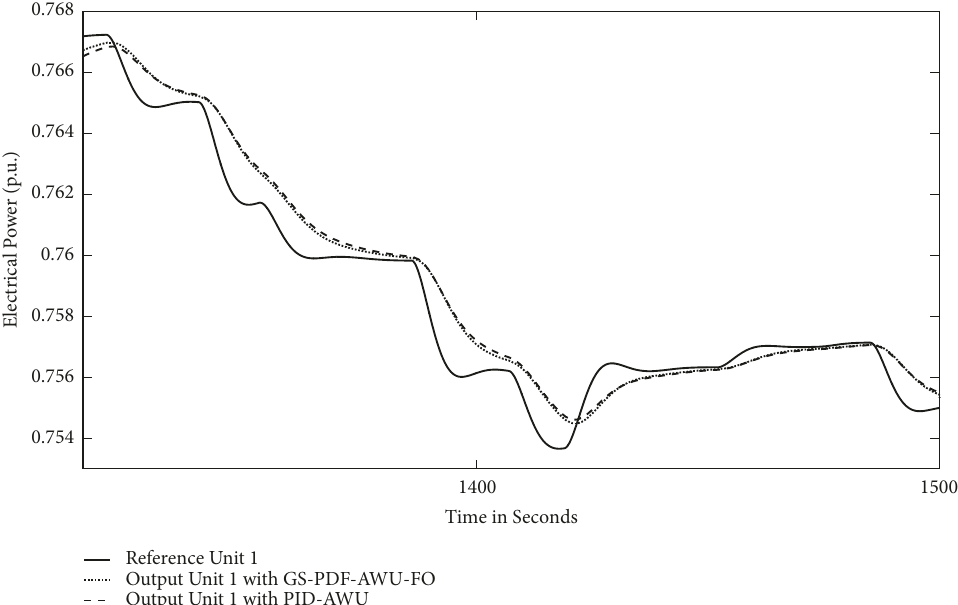
Figure 18: Evaluation of the responses produced by PID and GS-PDF-FO (both with antiwindup) with unit 1 in frequency variation (connected to the grid) and units 2-6 with 0.85 p.u. of fix operational point, h=0.9 p.u.